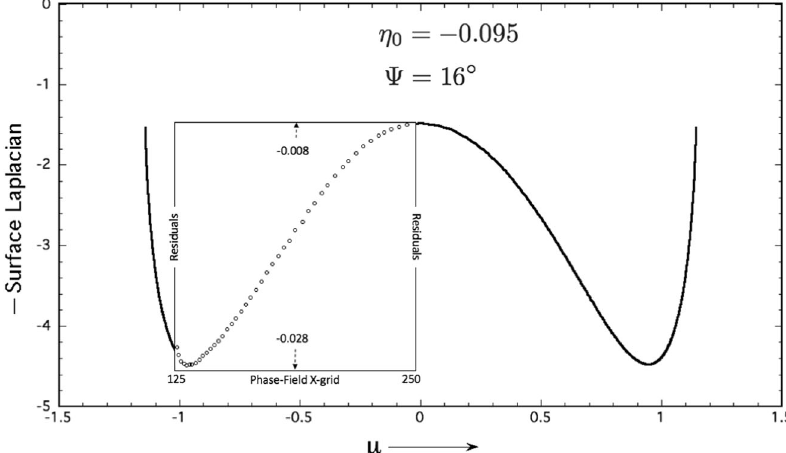
Fig. 6 Minus the surface Laplacian of the thermochemical potential versus μ -coordinate along a sharp GBG interface pro fi le ( η 0 = − 0.095, Ψ = 16 deg). The boxed insert contains data for 46 scaled temperature residuals [K], which are proportionate to the local capillary-mediated cooling rate. Residuals were measured independently along the phase- fi eld image isolines shown in Fig. 4. Residuals are the local isoline temperature minus the value of what a linear temperature fi eld would be at that point, were the gradient a constant equal to the total temperature difference spread over the total y -grid, divided by the box height. The calculated surface Laplacian for the sharp interface is proportionate to the cooling rate developed along diffuse s / ℓ isolines that have identical divergences of their tangential heat fl ux. Distributed interfacial cooling is responsible for the development of non-linearities in the temperature fi eld within the microstructure, as displayed in Fig.